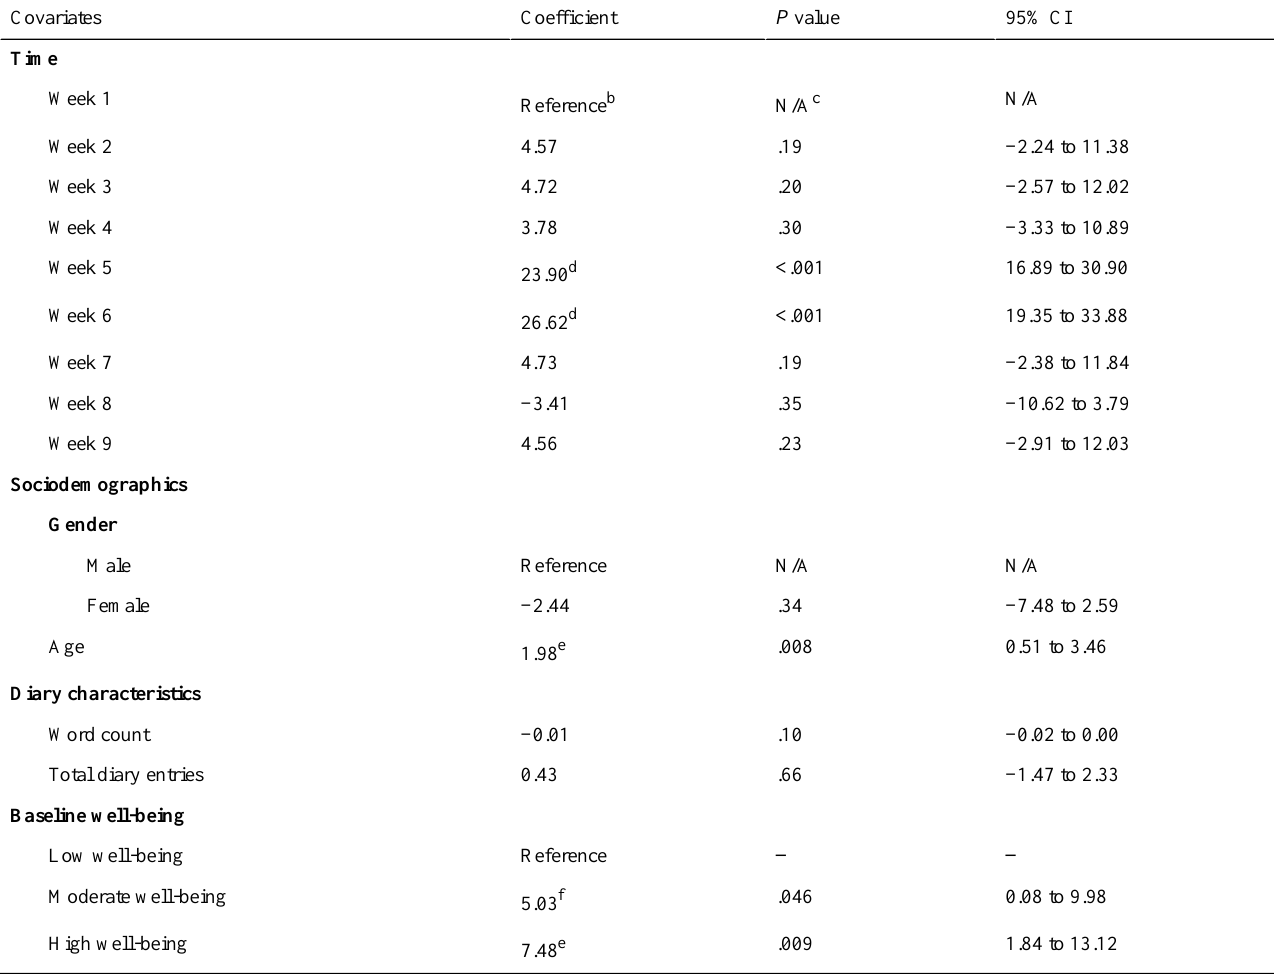
Table 5. Model 1: random effects generalized least squares regression examining the role of time (week effects), sociodemographics (age and gender), diary characteristics (word count and entries), and baseline well-being (moderate and high well-being, compared with low well-being) in determining the emotional tone of diary entries.